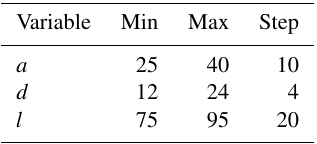
Table 1. SOLIDWORKS optimization